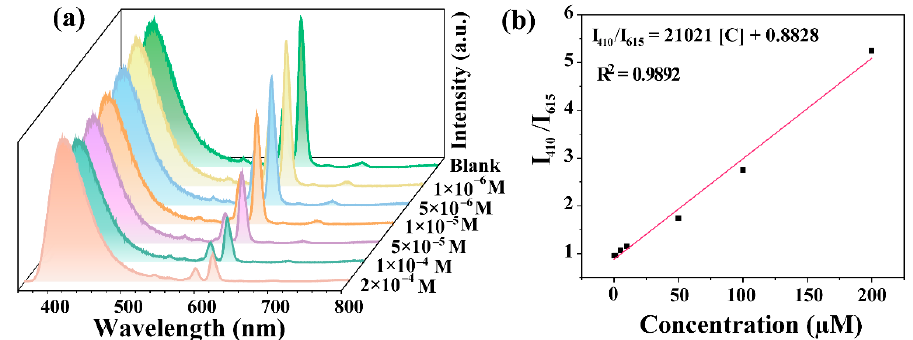
Figure 4. ( a ) The emission spectrum of CDs-F2 with Cu 2+ concentration. ( b ) The linear relationship between fluorescence emission intensity ratio I 410 nm /I 615 nm and Cu 2+ concentration.